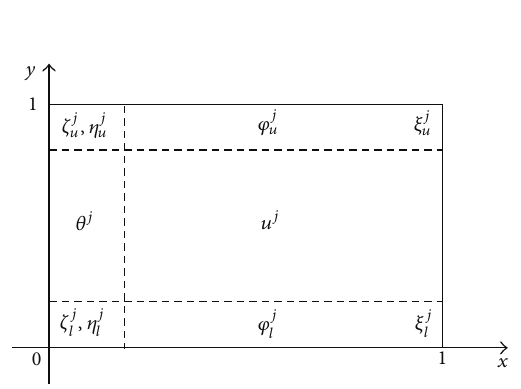
Figure 1: Location of the outer solution 𝑢 𝑗 and the boundary layer